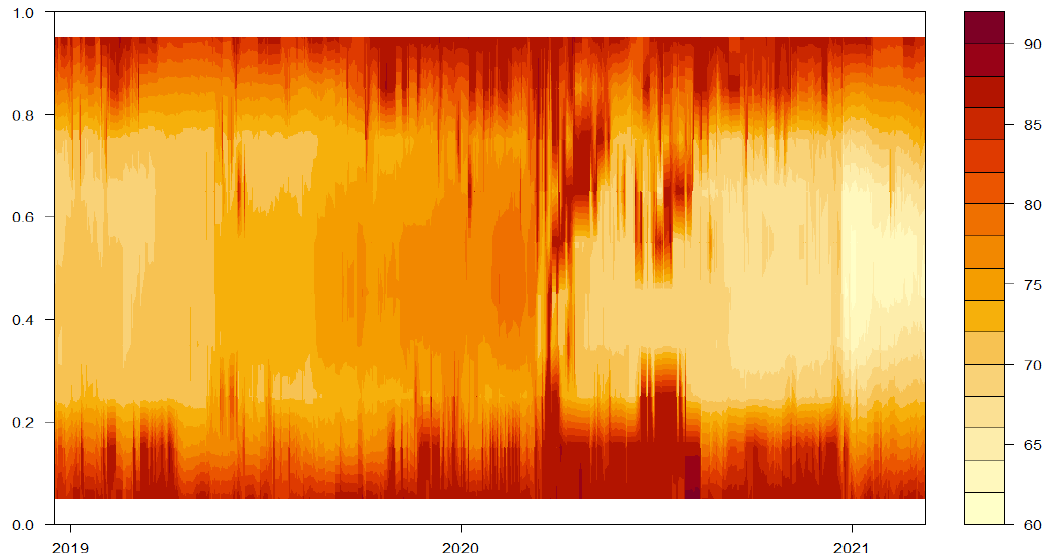
Figure 3. Results for dynamic total connectedness based on a 200-day rolling-window QVAR(1) model and a 20-step-ahead forecast.